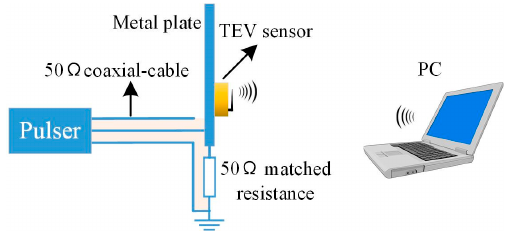
Figure 12. The experimental TEV PD calibration system.